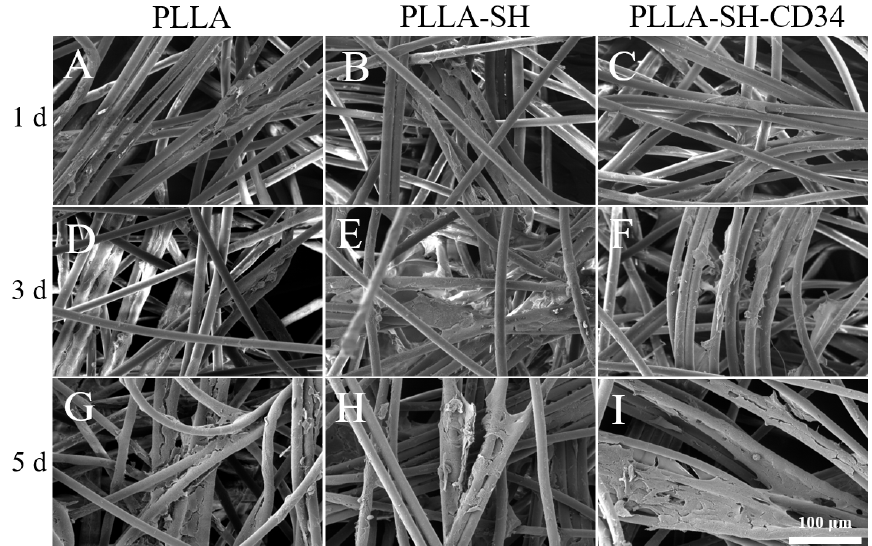
Figure 9. SEM images of endothelial cells on different scaffolds on days 1, 3, and 5. Nuclei staining and an adherence analysis of the cells on the fibrous membrane surface were performed at 1 h, 2 h, and 4 h. As shown in Figure 10, the adhesion of the cells on the fiber membrane surface changed with time as the cells spread out gradually. Compared with the rest of the materials, the red fluorescence outside the nucleus of the endothelial cells on PLLA-SH-CD34 was relatively bright after 4 h, and the cells were more spindle-shaped, which suggested that they were suitable for growth. These findings indicated that the PLLA-SH-CD34 membranes promoted the adhesion and growth of the endothelial cells.